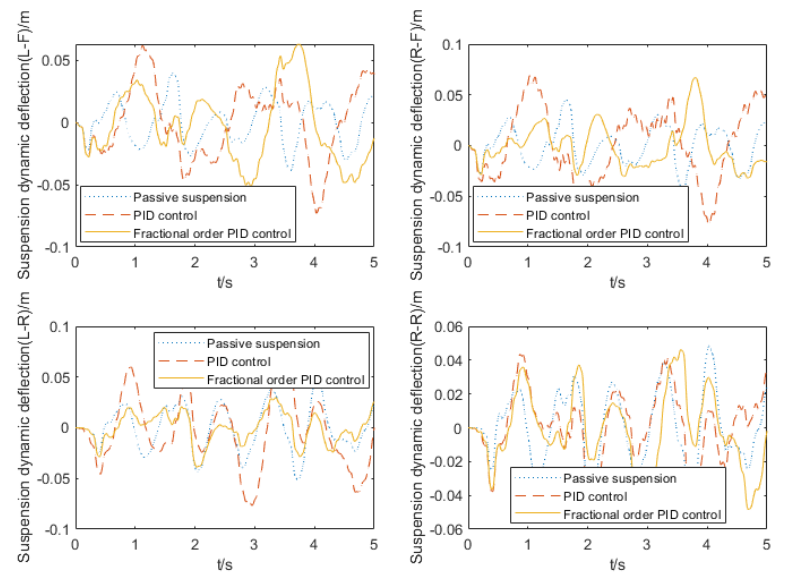
Figure 18. Suspension dynamic deflection simulation results.